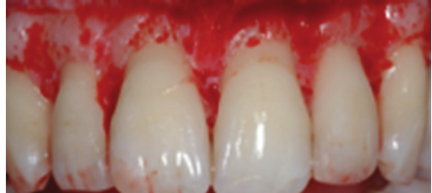
Figure 3: Normal biologic width in Subtype A.